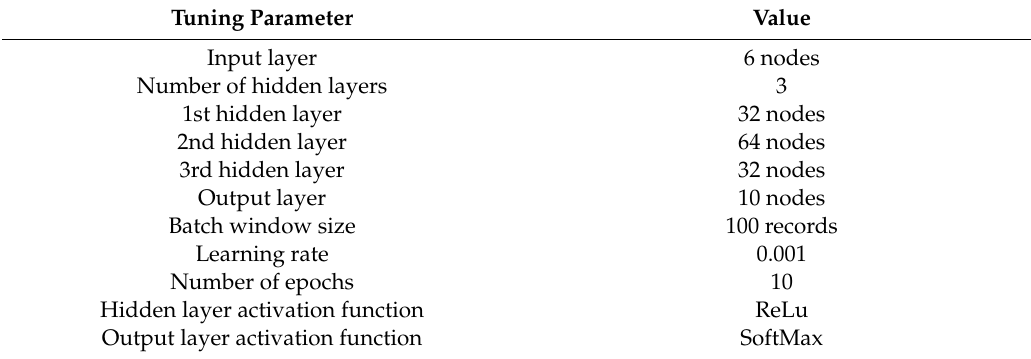
Table 9. Long short-term memory (LSTM) classifier tuning parameters.